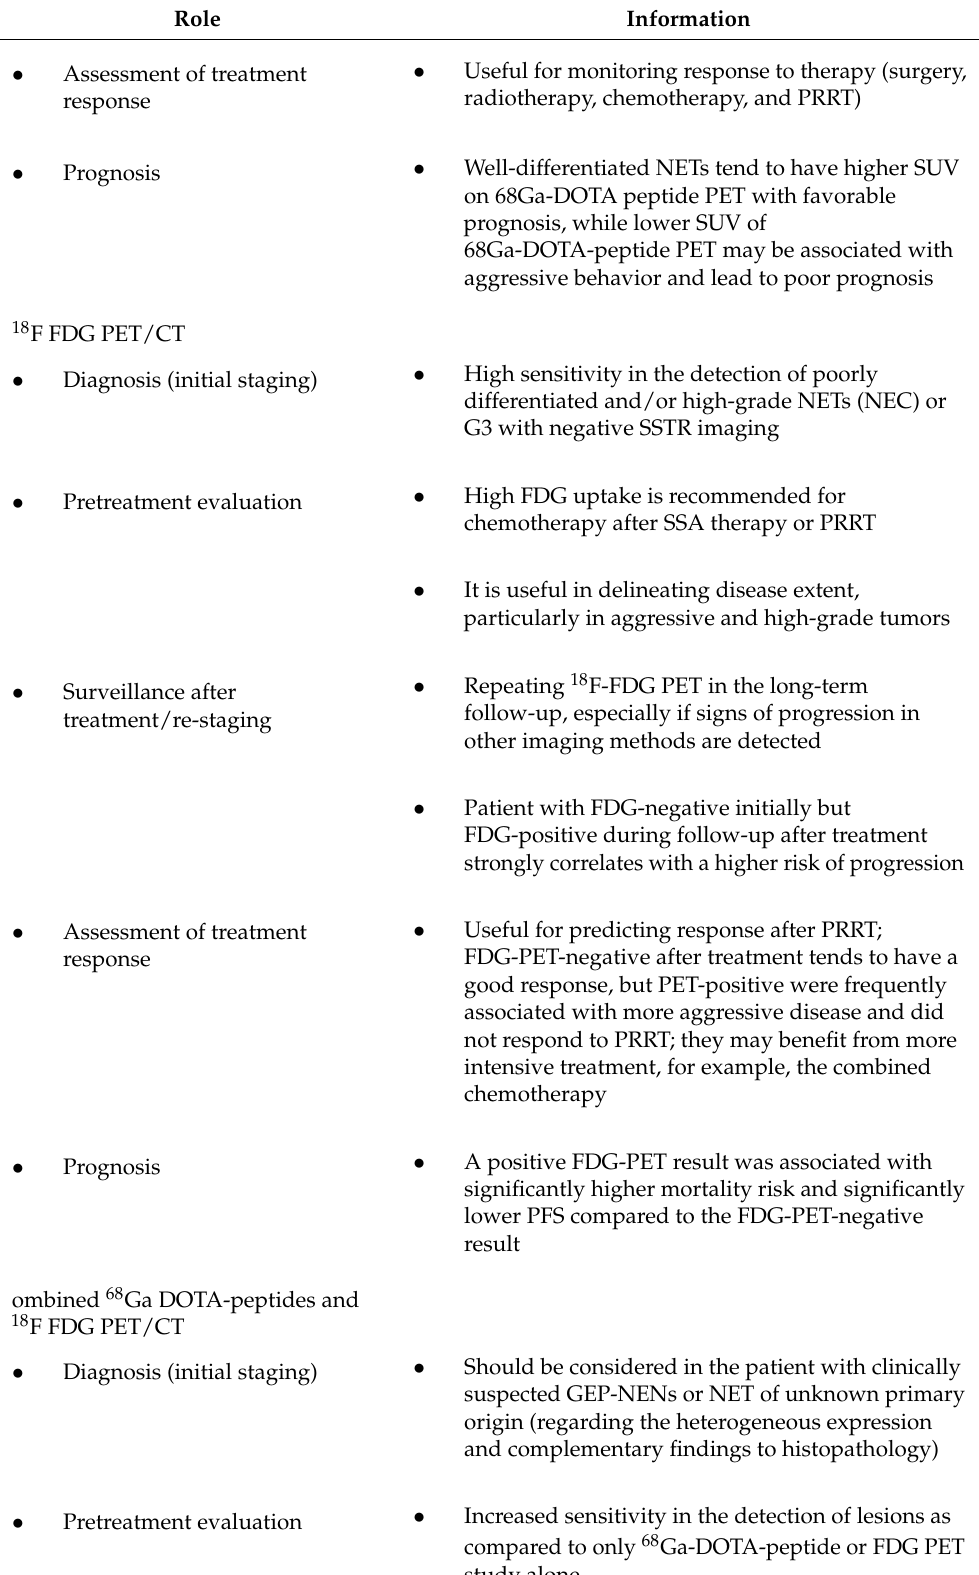
Table 4. Cont. Role